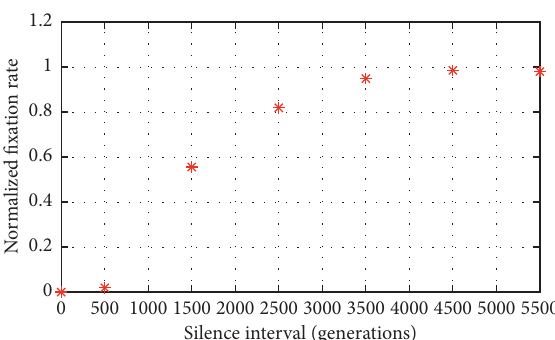
Figure 8: The relationship between the normalized fixation rate of the A1 allele and the duration of its silence interval in case of a population distributed over a spatial grid with m � 0 . 1.